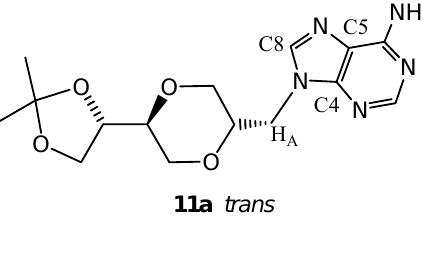
Figure 2. Structure of adenine homo- N- nucleoside analog 11a